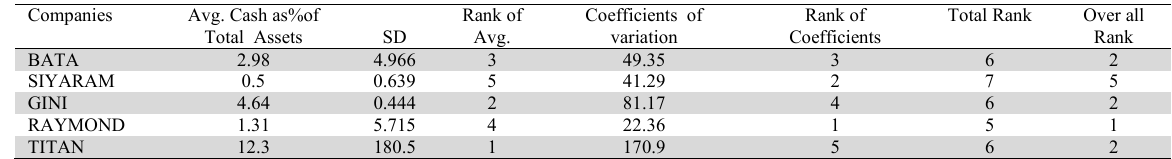
Ranking on the basis of average and consistency of average cash holding of the selected companies of retail sector